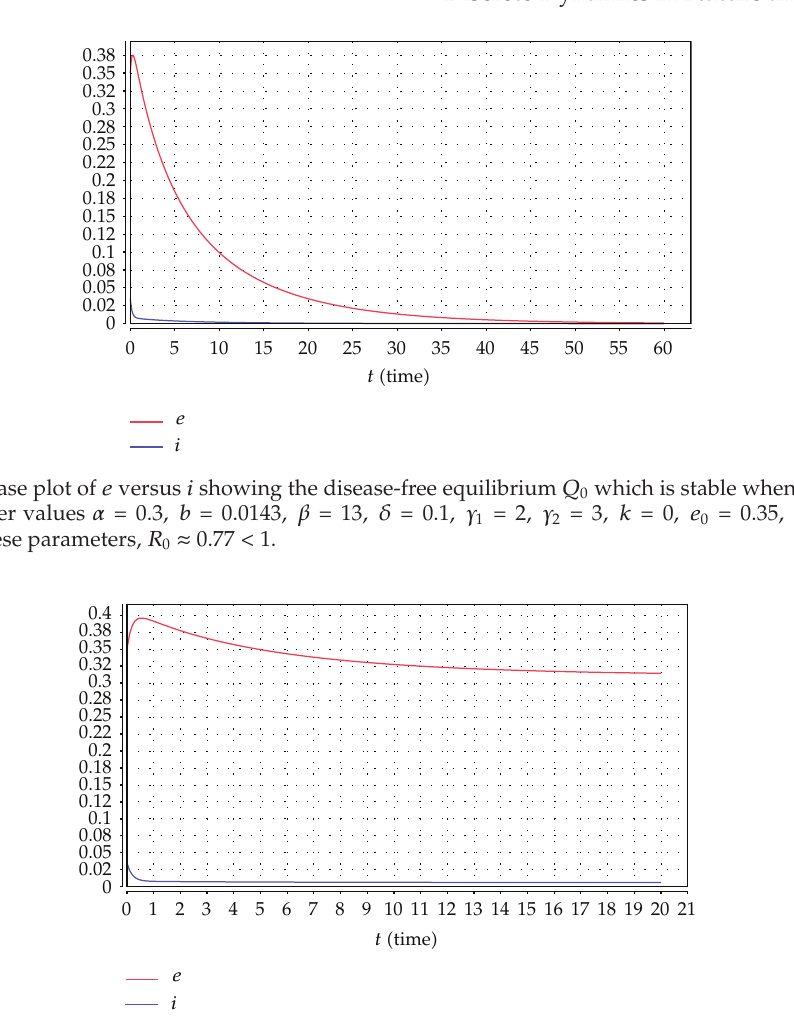
Figure 3: Phase plot of e versus i showing the existence of endemic equilibrium Q ∗ which is stable when > 1, for the parameter values for the parameter values k (cid:8) 0 . 02 and the others are the same as Figure 2. R 0 Based on these parameters, R 0 ≈ 1 . 398 >